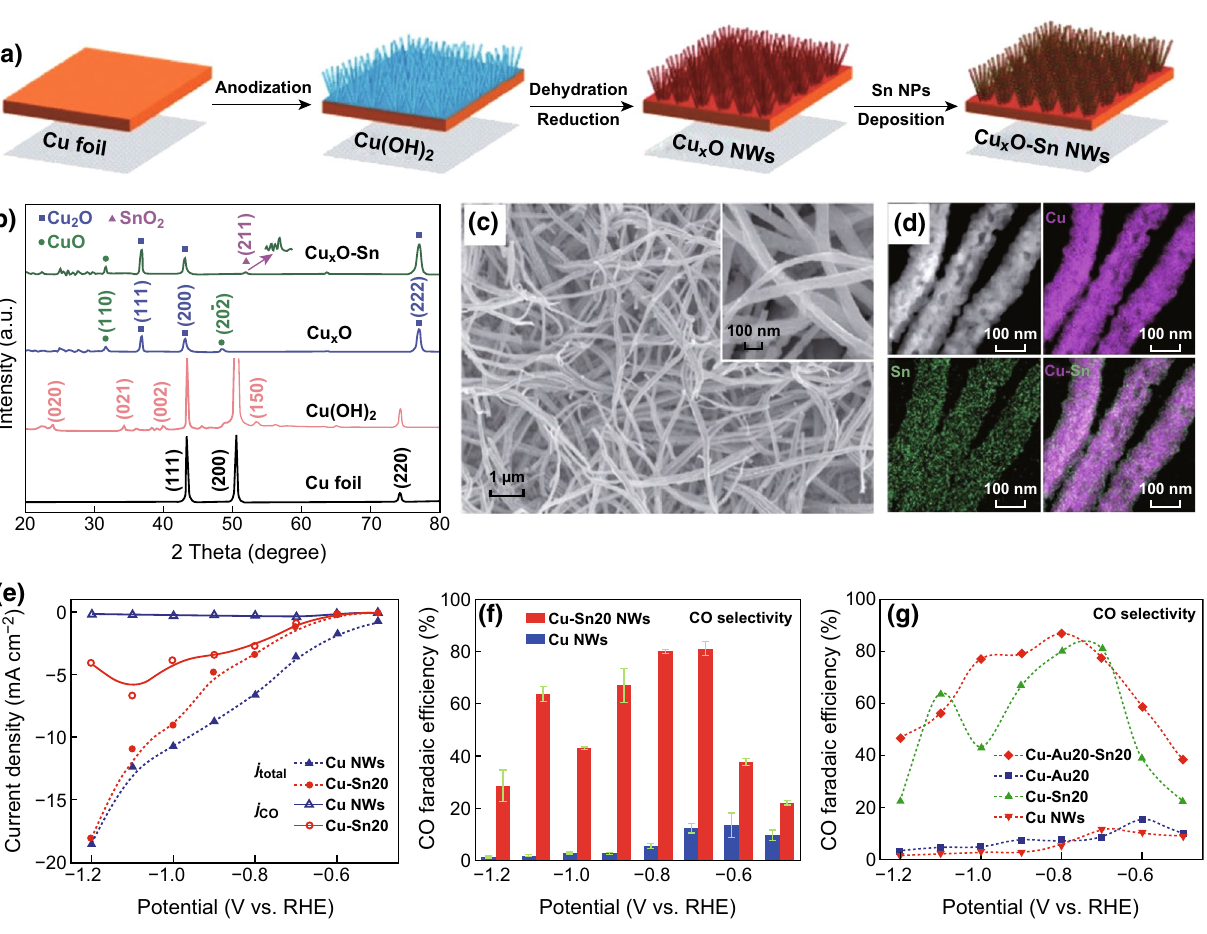
Fig. 4 a Illustration of the fabrication process of Cu x O‑Sn NWs. b XRD patterns of Cu foil, Cu(OH) 2 , Cu x O, and Cu x O–Sn. c Typical SEM images of Cu x O‑Sn NWs. d STEM elemental mapping results of Cu x O–Sn NWs. e Linear sweep voltammetry (LSV) curves in 0.1 M KHCO 3 solution for CO 2 electroreduction on Cu NWs and Cu–Sn NWs. f Comparison of the FE of CO at different potentials between Cu NWs and Cu– Sn NWs. g Potential‑dependent CO FE for Cu, Cu–Sn, Cu–Au, and Cu–Au–Sn NWs. Reprinted with permission from Ref.